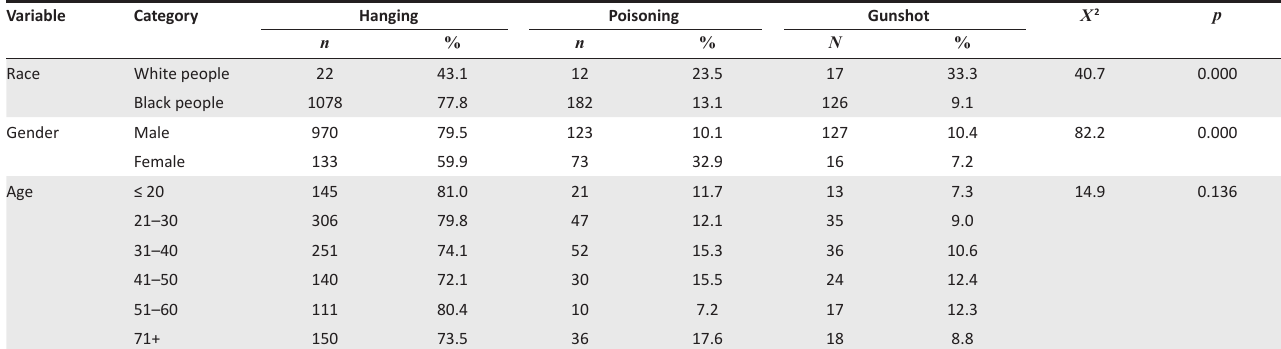
TABLE 2 : Common method of suicide by race, gender and age. Variable